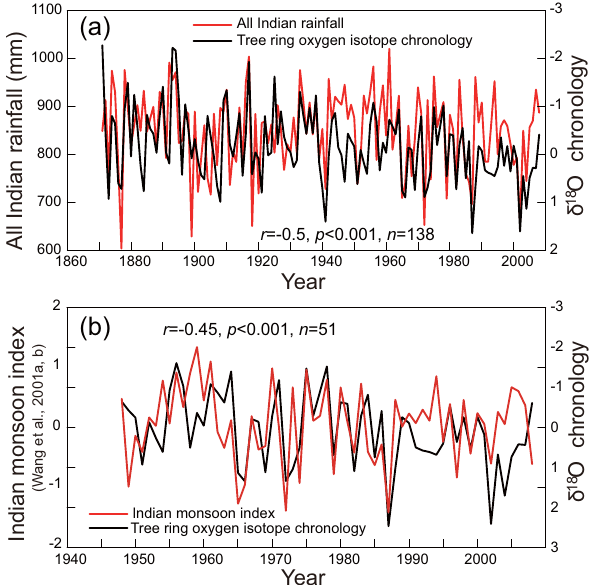
Figure 5. Comparison of the H5 regional tree-ring δ 18 O chronol- ogy with AIR (a) and IMI (b) .